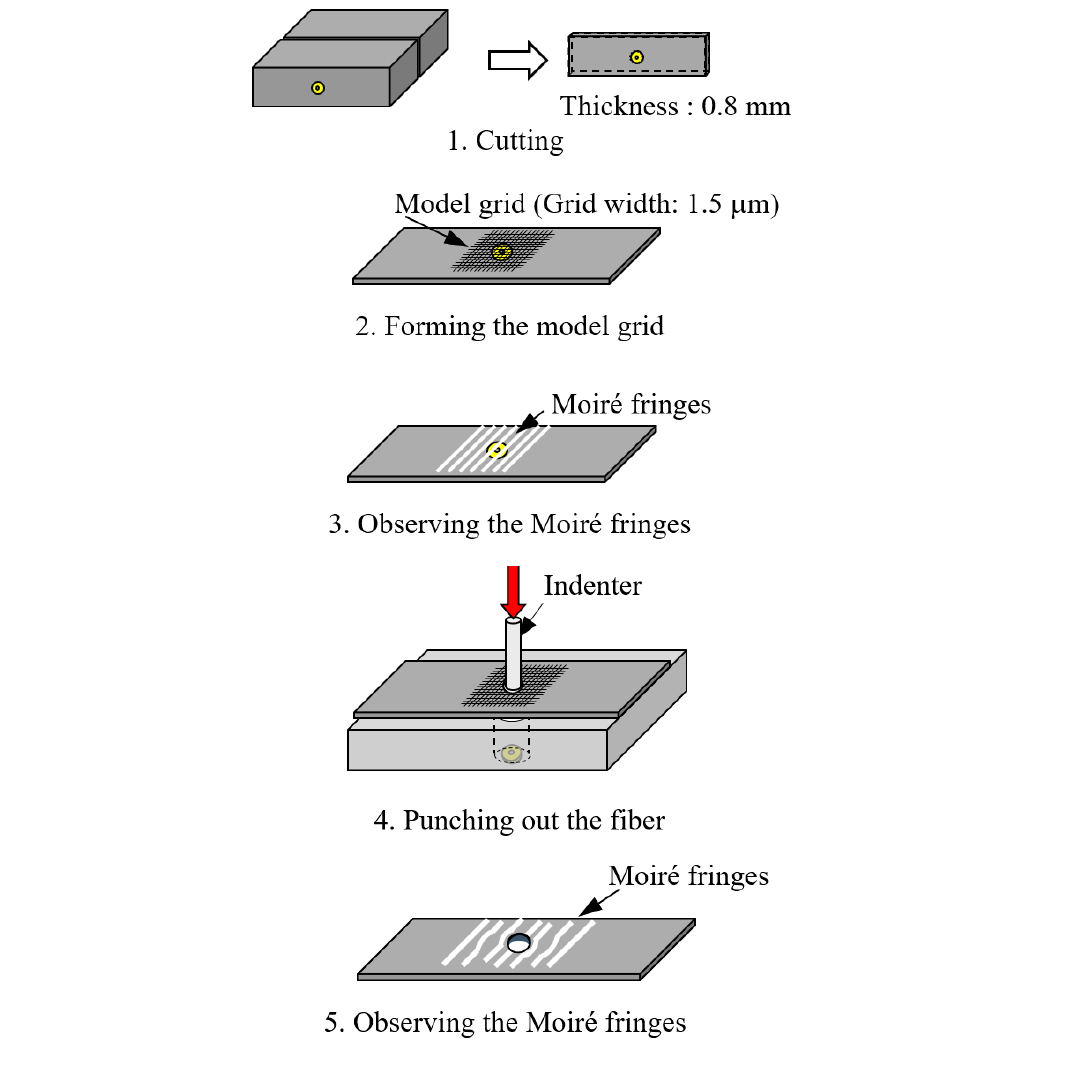
Figure 4. Experimental procedure of residual stress measurement by electron beam Moiré method.